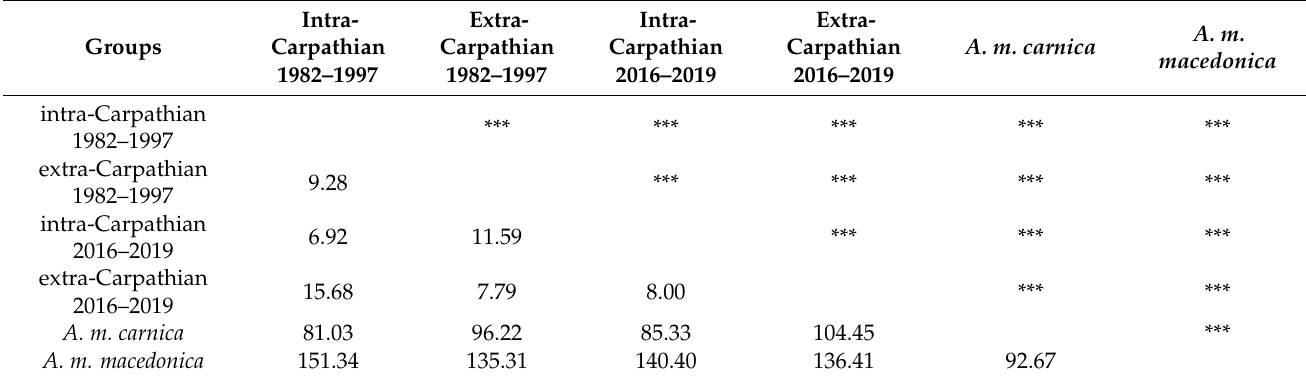
extra-Carpathian intra-Carpathian